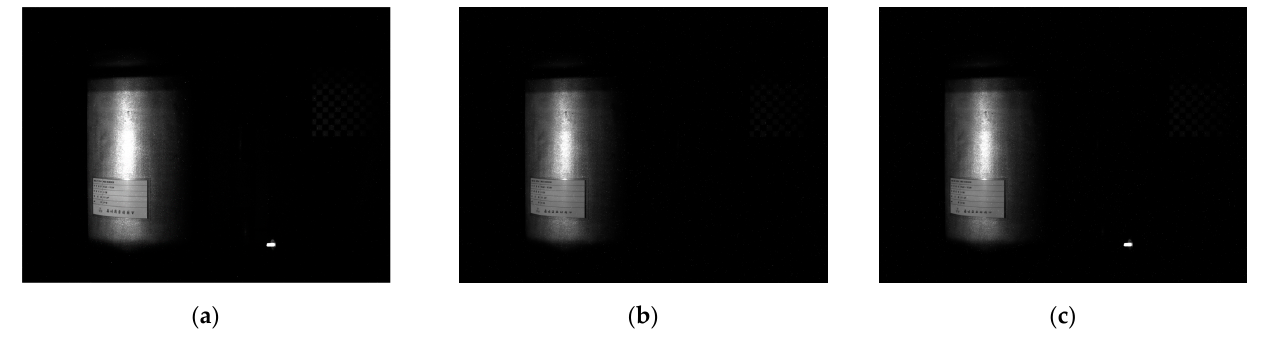
Figure 11. Images of Scanner: ( a ) At Start; ( b ) Before Abnormal Termination; ( c ) At End.